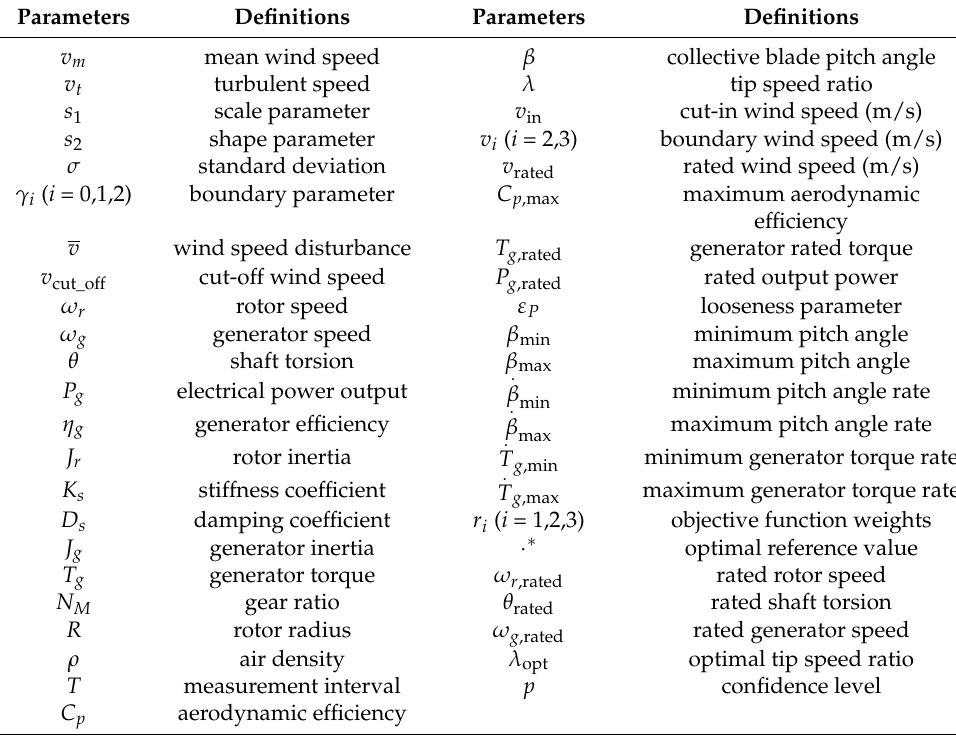
Table 1. The nomenclature of parameters for a 5 MW WPGS.